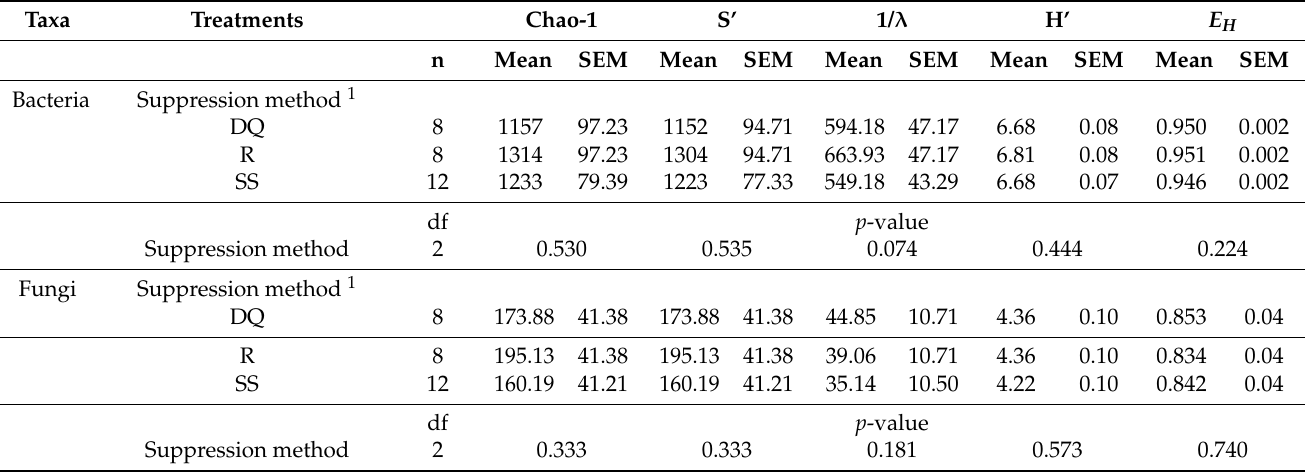
Table 3. Treatment mean values (mean), standard errors of the mean (SEM), number of observations (n), as well as probability values ( p -value), and degrees of freedom (df) associated with the ANOVA of the alpha-diversity metrics of Chao-1 index (estimated richness); S’, observed richness (observed ASVs); 1/ λ , reciprocal of Simpson index; H’, Shannon index; and E H , Shannon equitability